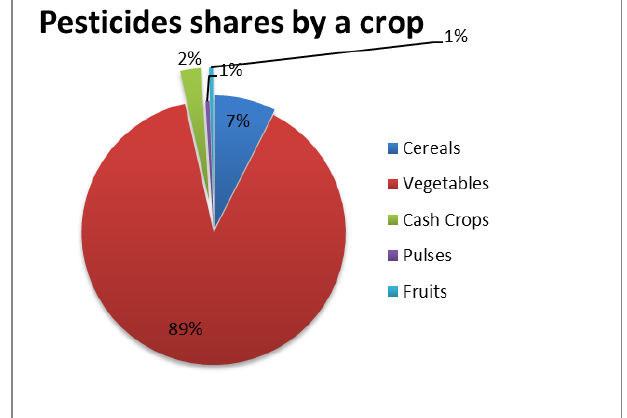
Figure 2: Pesticides shares by a crop (Source: Plant